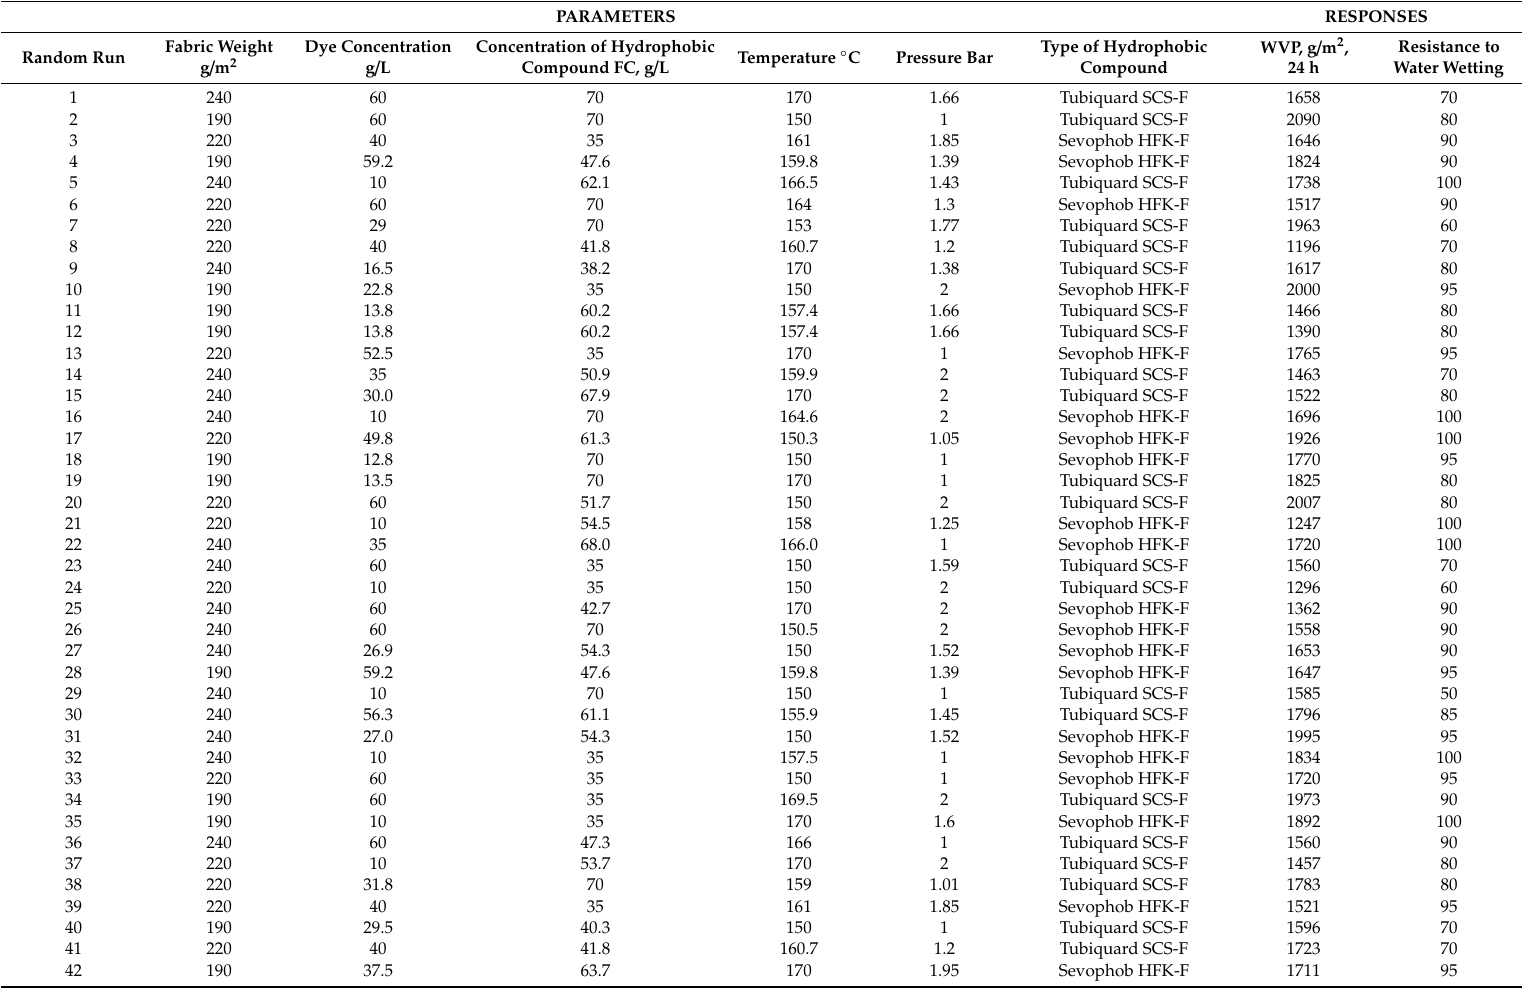
Table 2. Experimental planning in Design of Experiment, central composite design, six parameters, 42 preliminary experiments, six input parameters and two output